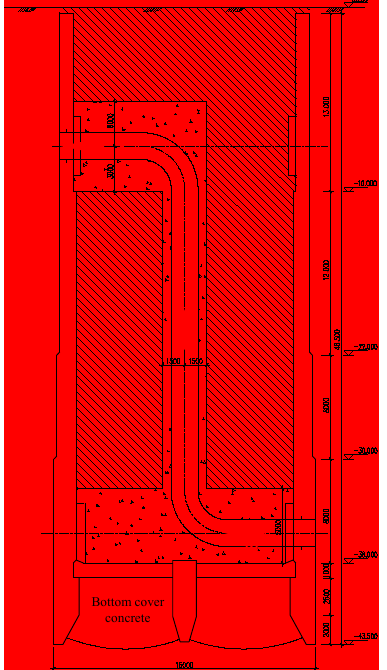
Figure 2. Schematic diagram of an open caisson.